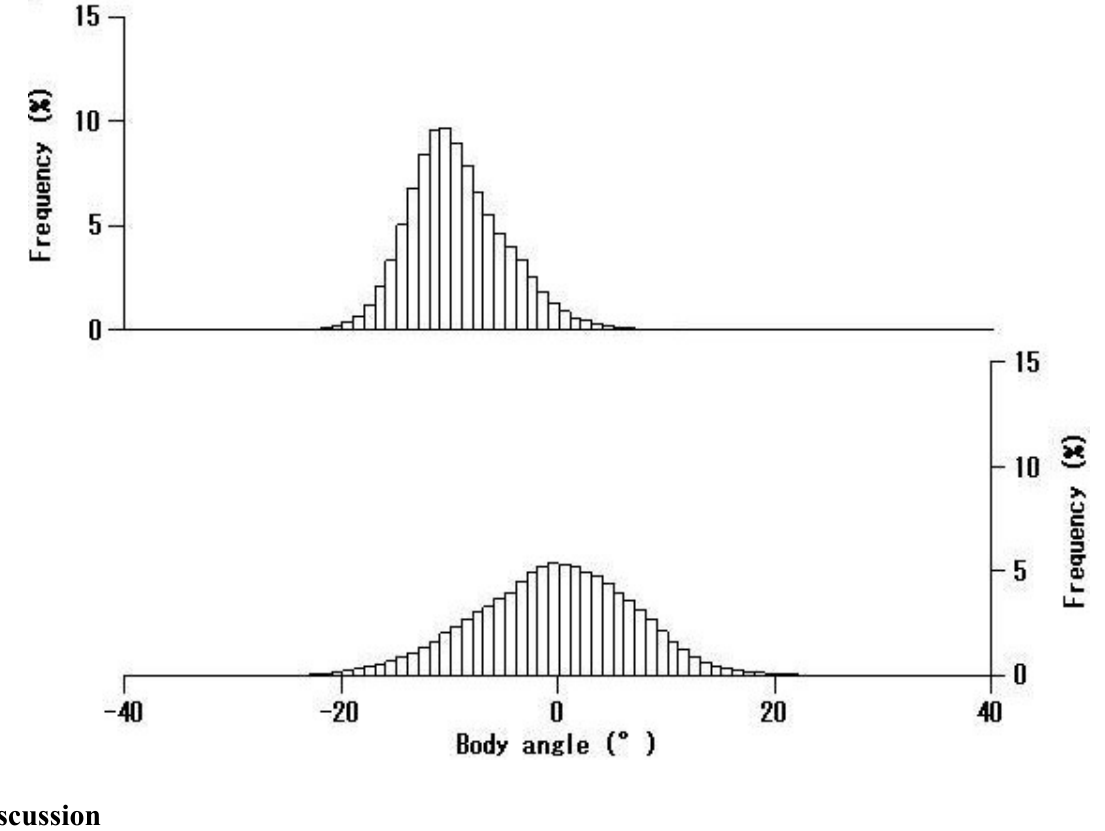
Figure 2. Tilt angle distributions in day (upper panel) and night (lower panel) measured for six individuals among a school of 20